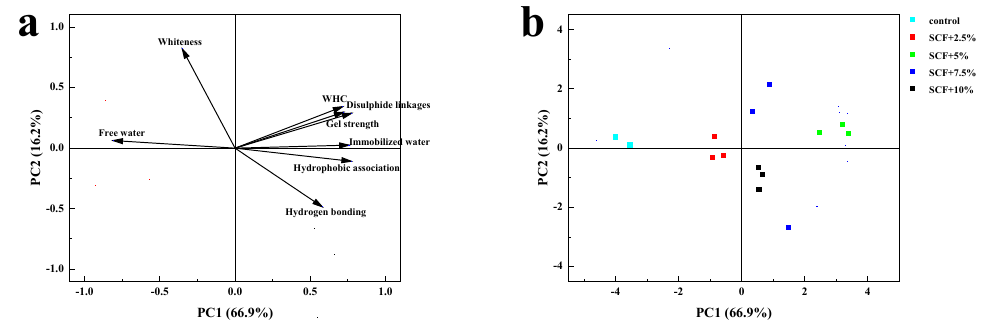
Figure 5. Graphical of principal component (PC) analysis of SCF and MP mixed gels of PC2 and PC1: ( a ) factor load and ( b ) factor score.